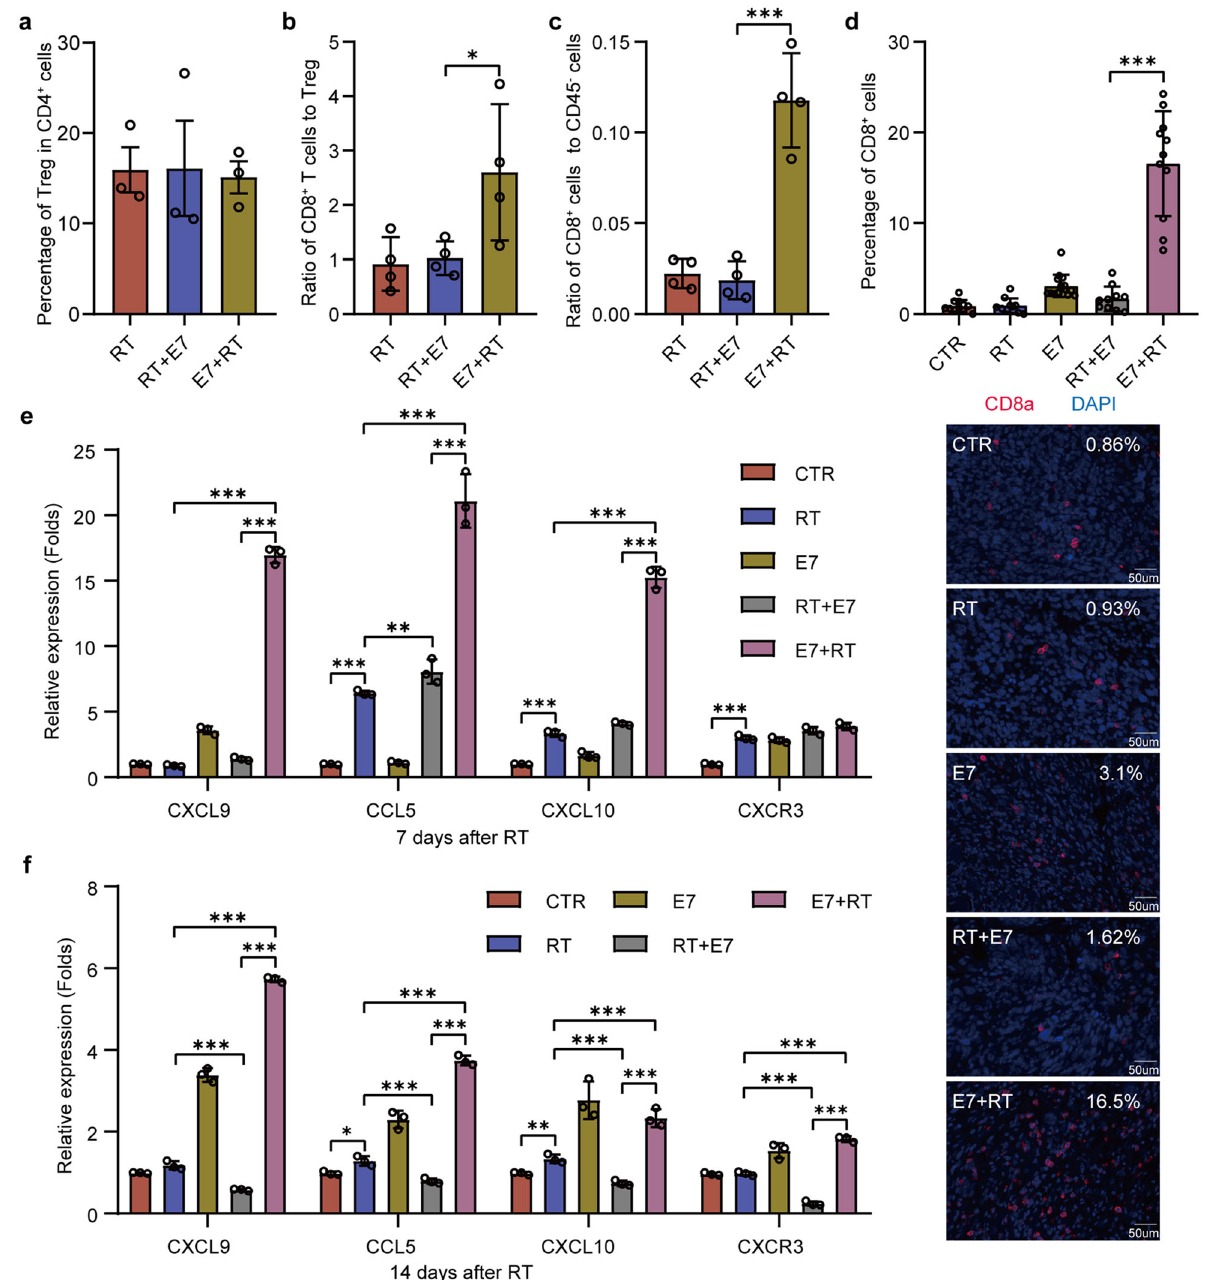
Fig. 4 Tumors treated by the combinations of E7 vaccines before or after radiation showed bigger difference in the ratios of CD8 + /Treg cells. Local established tumor treatments were followed by the experimental procedures described as in Fig. 3a. On days 7 and 14 after radiation, tumors were collected for fl ow cytometry, immuno fl uorescent staining, and RT-PCR analyses. a Percentage of Tregs in CD4 + cells analyzed using fl ow cytometry. b The ratio of CD8 + /Tregs in tumors analyzed using fl ow cytometry. c The ratio of CD8 + /CD45 − cells in tumors analyzed using fl ow cytometry. d From each group 3 tumors were used for the immuno fl uorescent staining of CD8. Slides were incubated with anti-CD8 primary antibodies overnight in 4 °C and then with corresponding secondary antibodies (RED), then stained the nucleus with DAPI (BLUE). 10 to 12 fi elds of view in each treatment group were imaged and analyzed (Upper). The pictures were merged by image software (Lower). Percentage of CD8 + positive staining cells was analyzed using Image-Pro Plus software. e , f Whole tumor RNAs were isolated from the tumors of treated mice. Real-time PCR measurement of the expression of CXCL9, CCL5, CXCL10, CXCR3 in tumors after radiation for 7 days ( e ) and 14 days ( f ). Data were presented as mean ± SD; n = 3 to 4 mice/group. Experiments were repeated three times and two-tailed t -test was used for comparisons of biological replicates. * P < 0.05, ** P < 0.01, *** P < 0.001, **** P < CD8 + CXCR3 + IFN- γ + and CD8 + CCR5 + IFN- γ + cells from in CD8 + T cells, and expression levels of chemokines, such as tumor tissue suspension (Supplementary Fig. 8). As shown in CCL5 and CXCL9/10. Our results demonstrated that the elevated Fig. 5e, f, compared with other treatments, E7 + RT treatment levels of CCL5 and CXCL10 produced by the irradiated tumors induced the increases of CD3 + CD8 + T cells recruitment, might attract the vaccinated CD8 + T cells with a high expression percentages of CXCR3 + IFN- γ + cells and CCR5 + IFN- γ + cells of IFN- γ + CXCR3 + into the tumor, resulting in an increased ratio